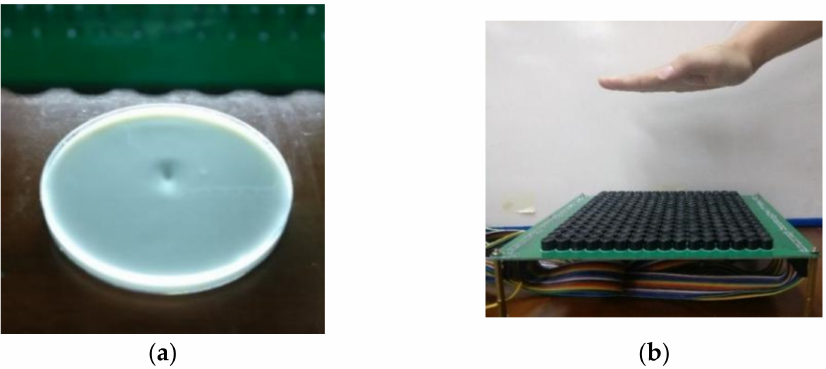
Figure 10. Single-point haptic feedback. ( a ) Liquid surface of single-point focus. ( b ) Haptic sensing to the palm.